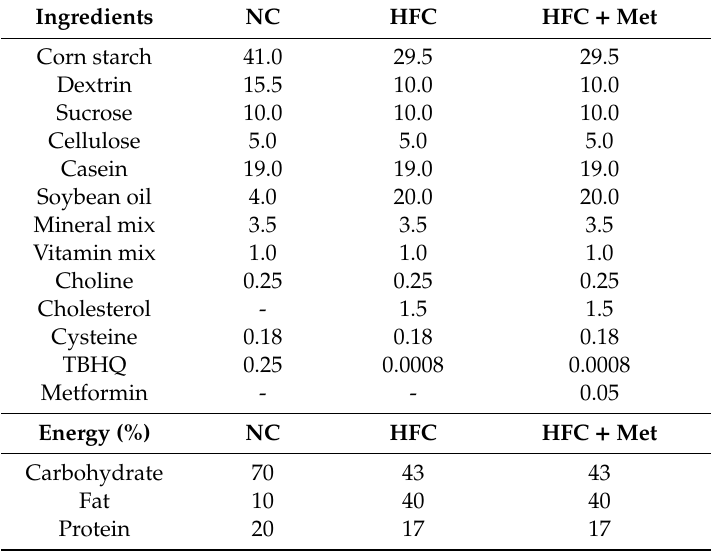
Table 1. Ingredients of the normal diet, the high-fat and high-cholesterol diet, and the high-fat and high-cholesterol diet with metformin